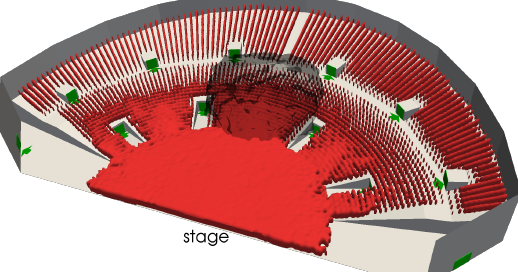
Figure 21. Configuration of the concert hall simulation. The exits are marked in green and the person initial positions of people are indicated in